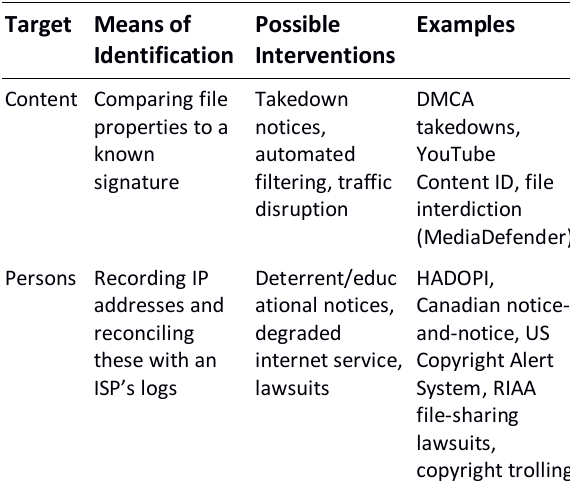
Table 1. Two basic types of copyright surveillance and associated